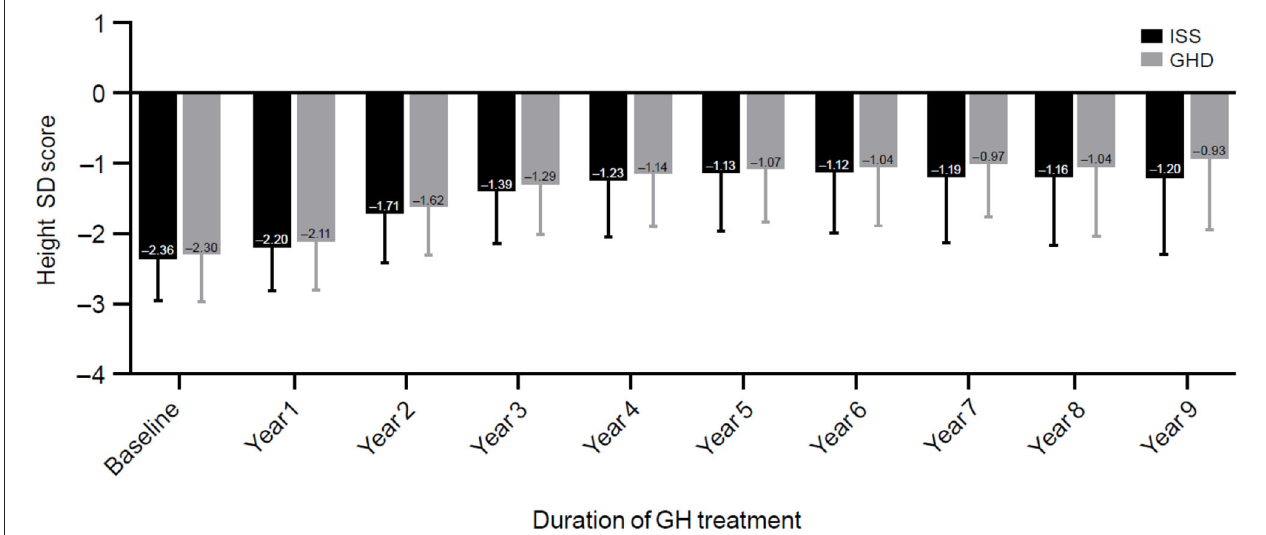
FIGURE 3 | Changes in height standard deviation score. ISS, idiopathic short stature; GH, growth hormone; GHD, growth hormone deficiency, SD, standard deviation; SDS, standard deviation